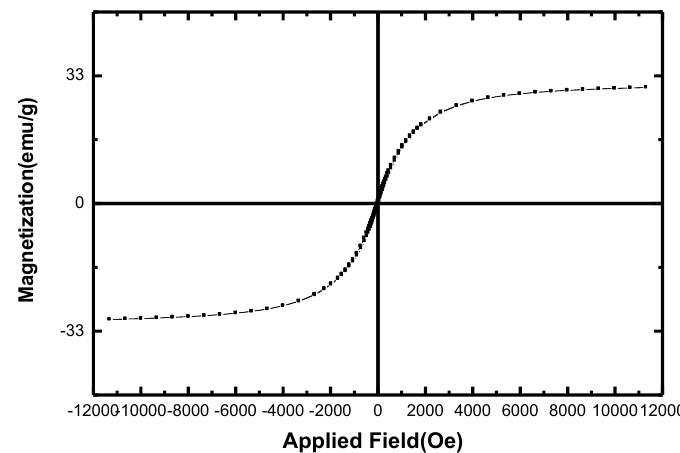
Fig. 10. Room temperature hysteresis loop of PS-Fe